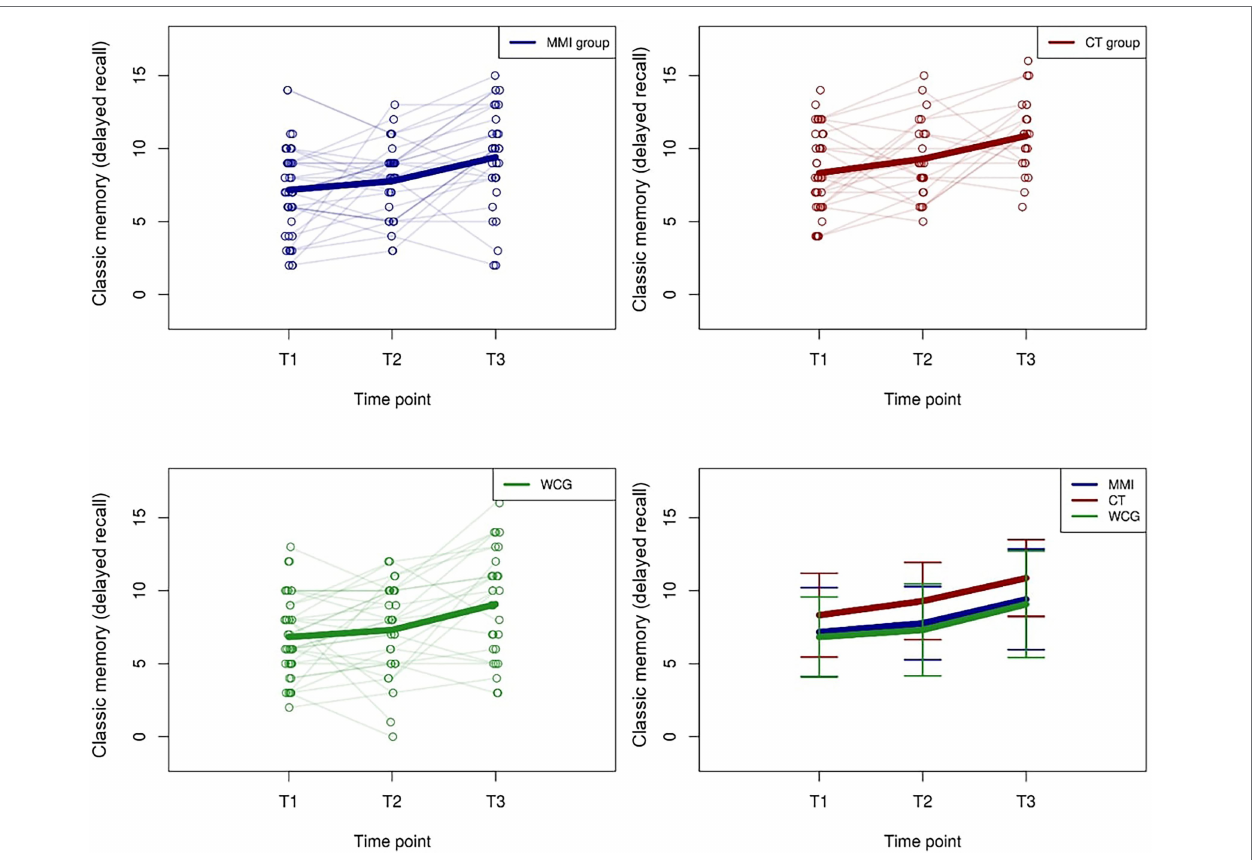
FIGURE 2 | Trajectories of “classic memory (delayed recall)” values for the MMI group, the cognitive training (CT) group, and the WCG. The thick lines indicate the mean